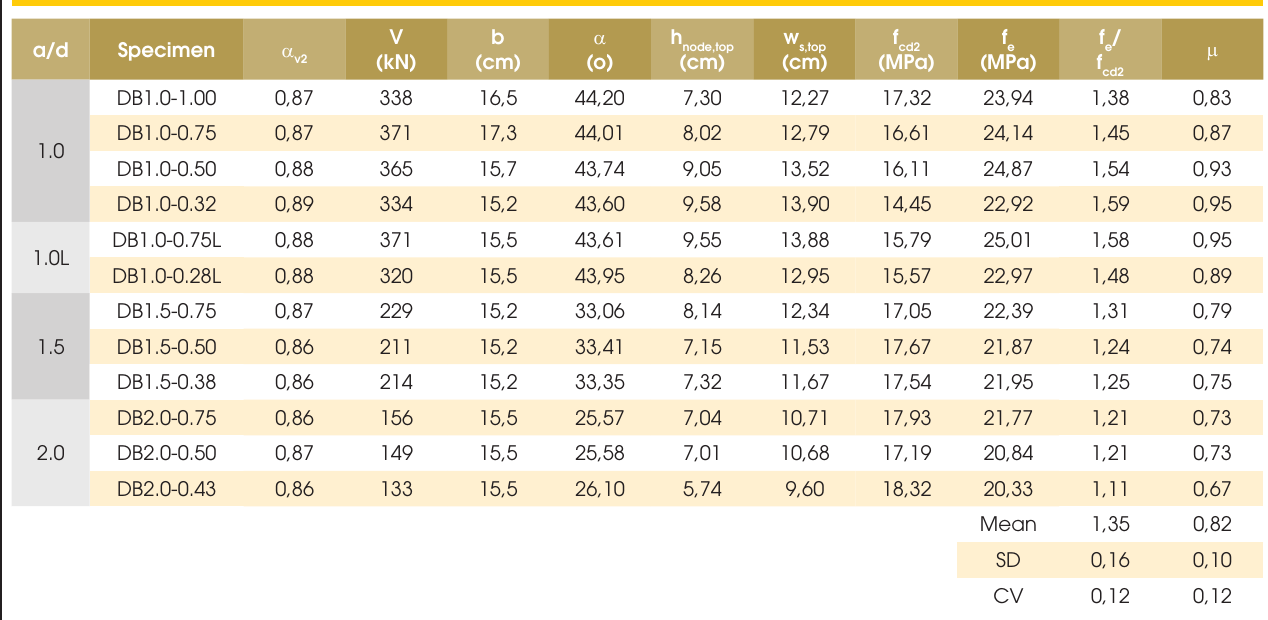
Table 2 – Bottle-shaped strut strength evaluation according to NBR6118